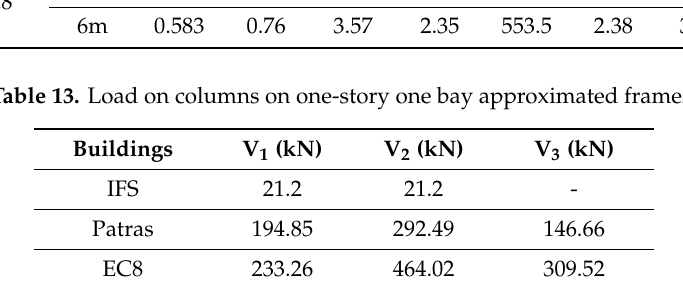
Figure 14. Approximation model for multi-storey multi-bay infilled frame EC8.